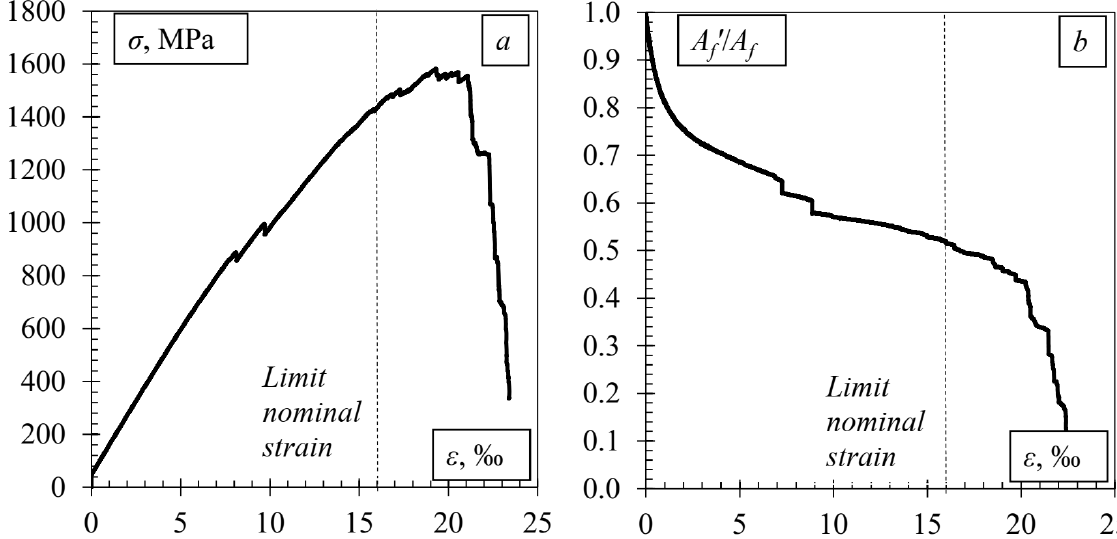
Figure 6. CFRP direct tension test results: ( a ) stress and strain dependence graph; ( b ) reduction in the effective resistance area to the applied force.